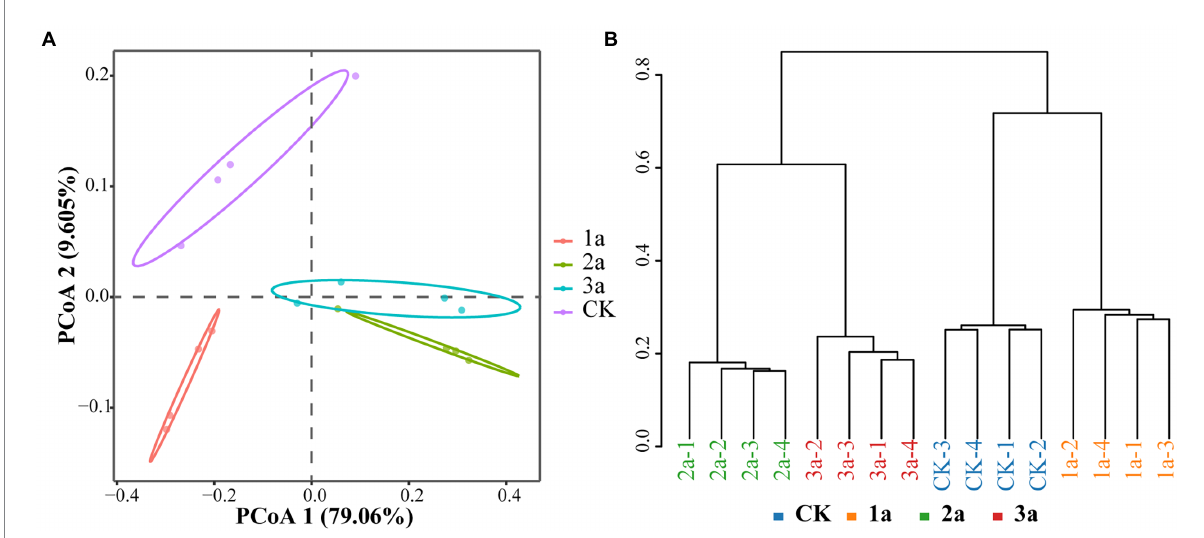
FIGURE 2 Differences in microbiota community structure based on principal coordinate analysis ( A , PCoA) and cluster analysis ( B , calculated on Bray-Curtis). CK, 1a, 2a, and 3a represent greenhouses consecutively planted for 0, 1, 2, and 3 years, respectively.